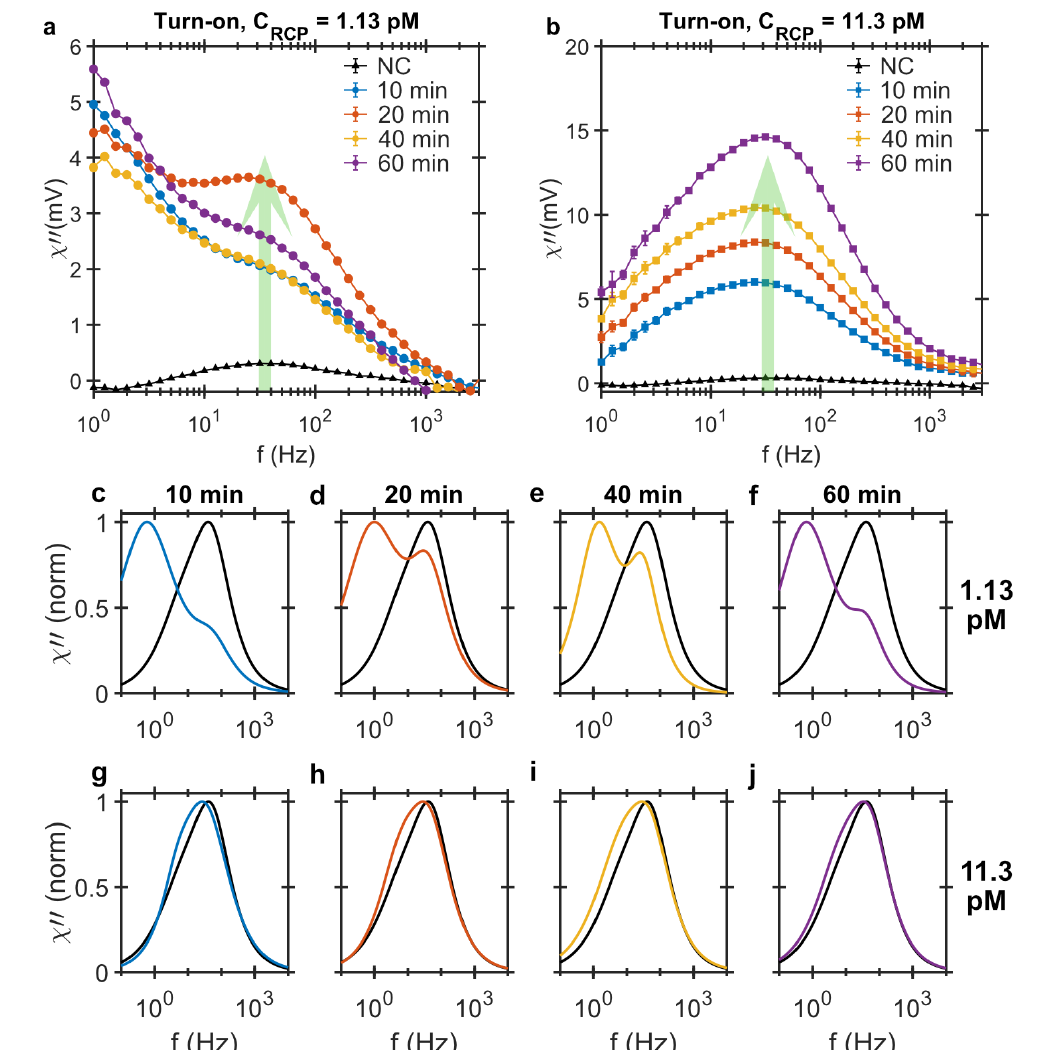
Figure 2. Imaginary component of ac magnetic susceptibility measured using the turn-on detection strategy versus the excitation frequency from MNP-labeled RCPs of ( a ) 1.13 pM and ( b ) 11.3 pM in concentration amplified for 10, 20, 40 and 60 min. The dilution samples are prepared using hybridization buffer. All the samples are measured using the NC as the control. The detection signal in this case increases with increasing RCP concentration and amplification time. The LRF (<15 Hz) distribution at low concentration is distinctly present in the turn-on measurement strategy; ( c – j ) Normalized bi-modal Cole-Cole model fitted to the imaginary component of turn-on strategy for the MNP-labeled RCPs of ( c – f ) 1.13 pM and ( g – j ) 11.3 pM rolled for 10, 20, 40 and 60 min. The black curve that is present in all the panels corresponds to the bi-modal model fitted to the NC